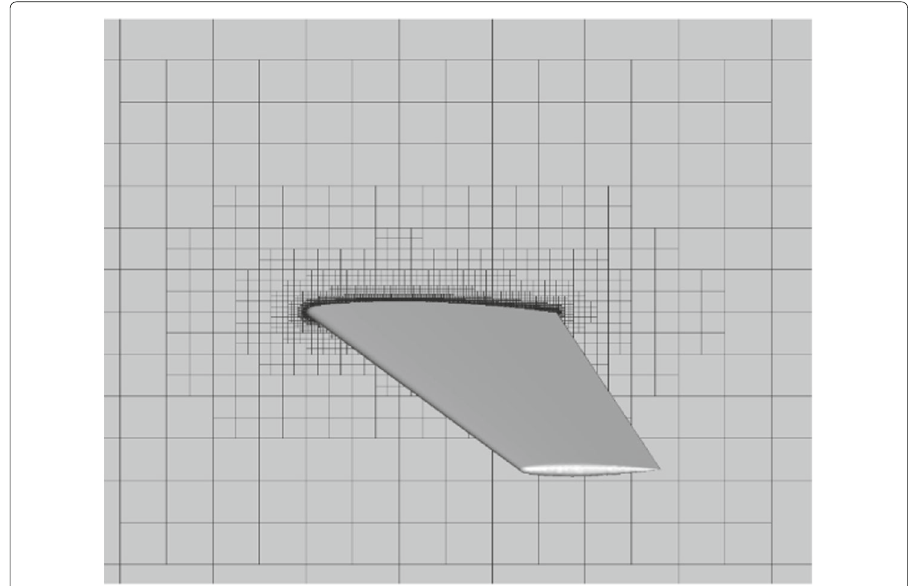
Fig. 21 The initial computational grids with geometry-based